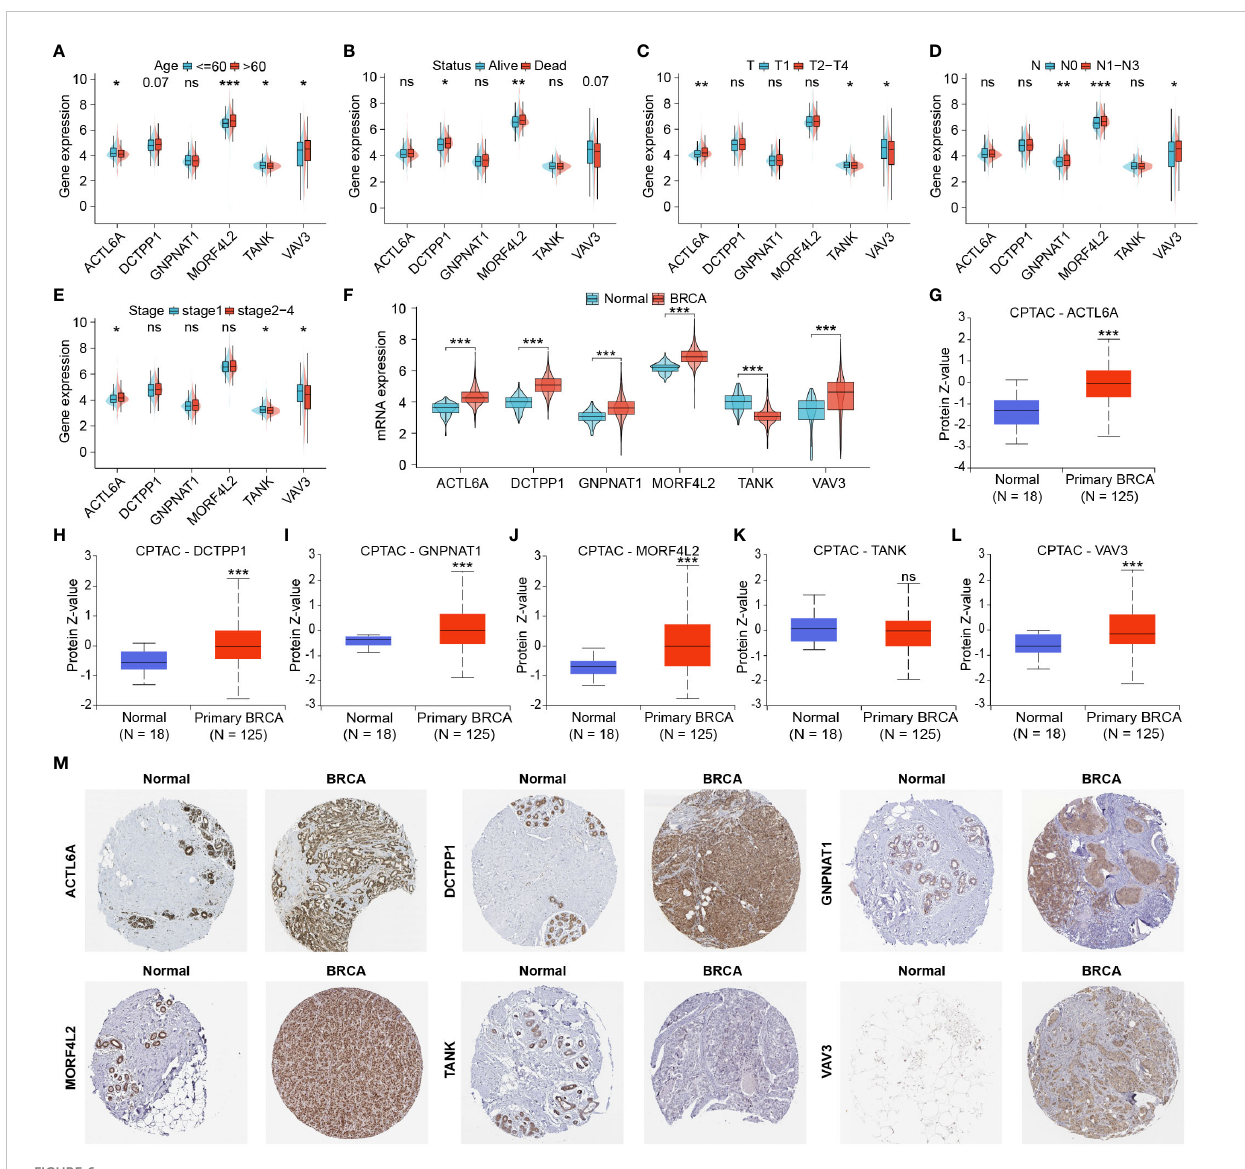
FIGURE 6 Identi fi cation and protein expression of DRGs associated with clinicopathological features. (A – E) DRGs differentially expressed in different clinicopathological subgroups. (F) Differential mRNA expression of six DRGs associated with clinicopathological features in normal and tumor tissues. (G – L) Proteomic expression of six DRGs based on CPTAC database. (M) Immunohistochemical images derived from the HPA database showed the levels of six proteins in normal and tumor tissues. (ns: not signi fi cant, * P < 0.05, ** P < 0.01, *** P <